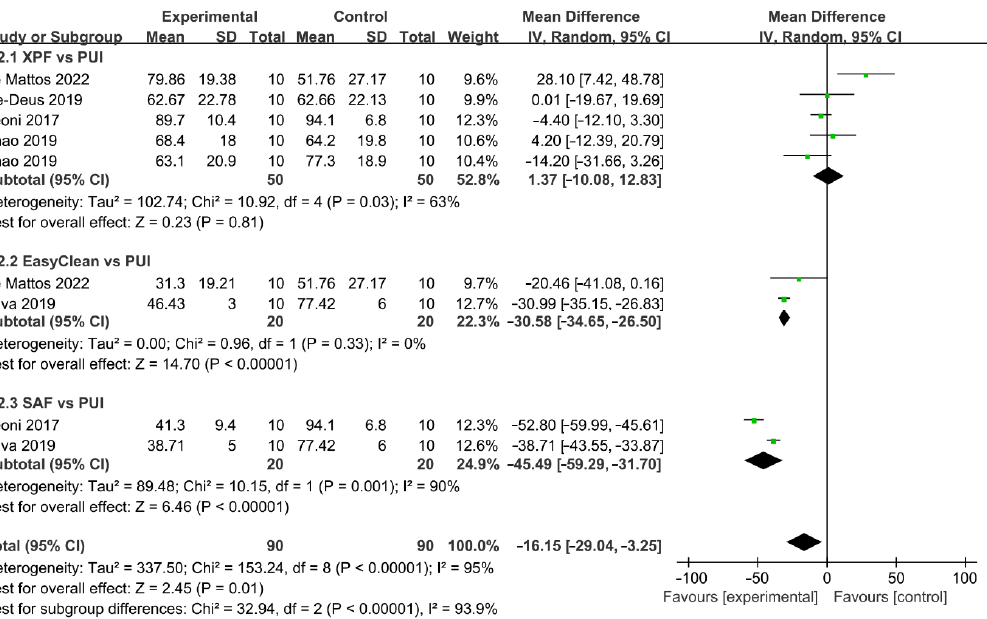
Figure 7. Forest plot and meta-analysis of comparison between mechanical-activated system and PUI [37,38,40,42,43].